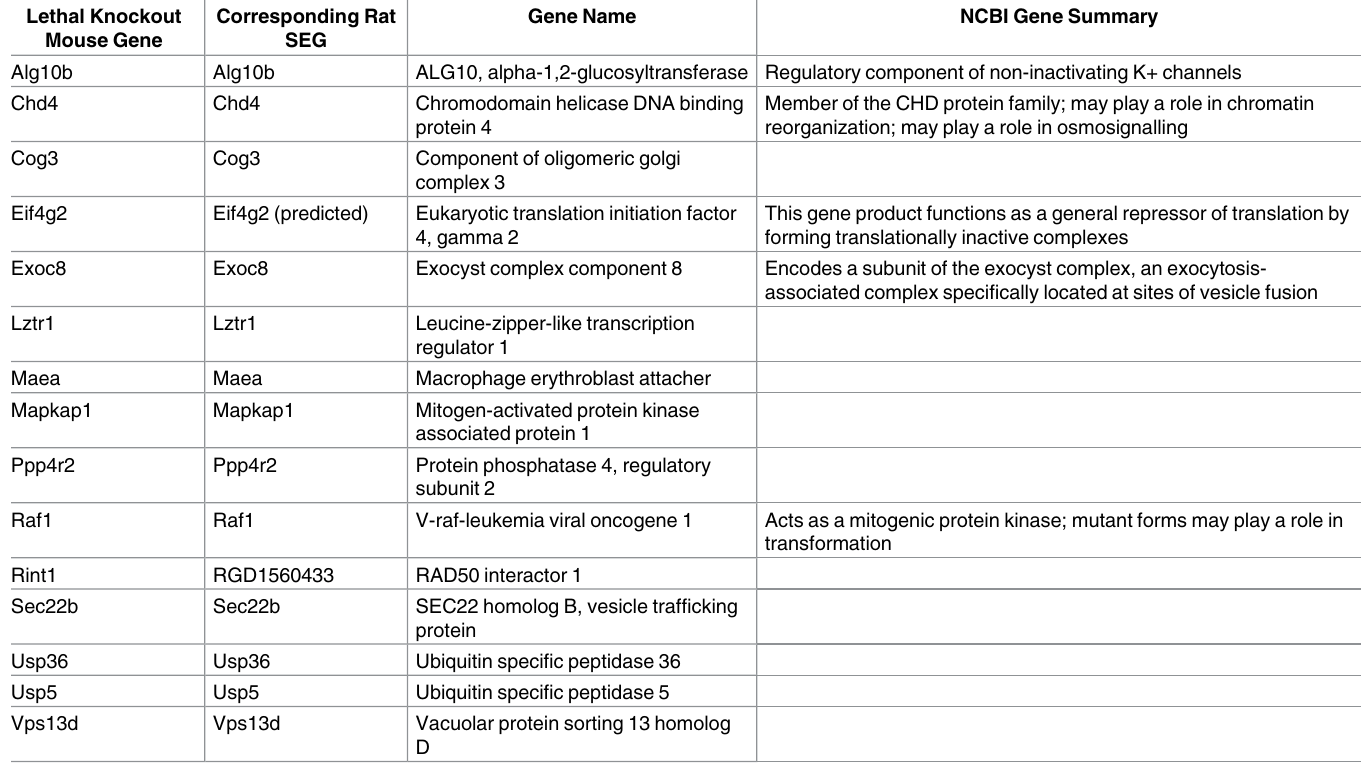
Table 4. Summaryof SEGs with lethal knockout